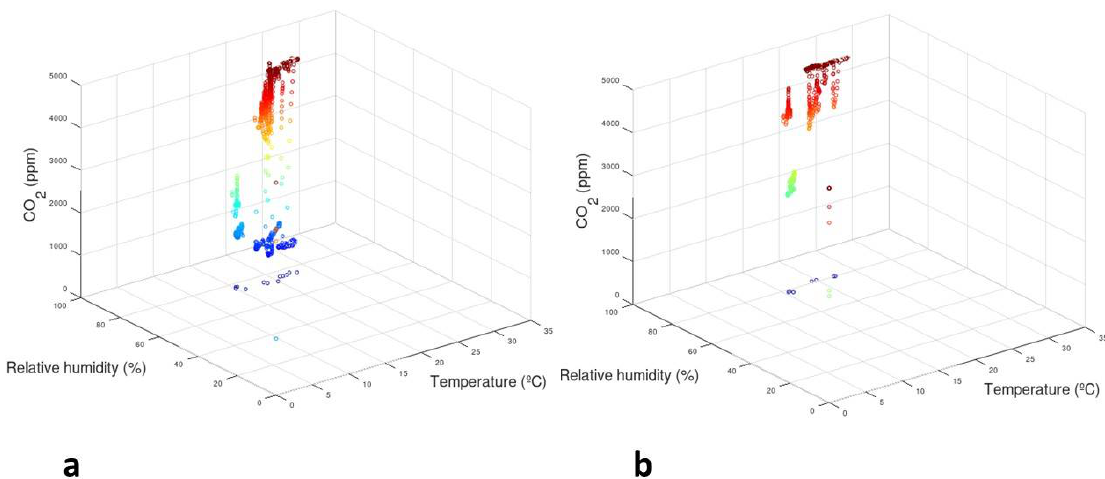
Figure 2. Graphical representation of relative humidity, temperature, and CO 2 data from barrels with maize grains stored for six months. ( a ) Maize from JC3 plot; ( b ) Maize from JC4 plot. The color of the markers is determined by the CO 2 level, from red (5000 ppm) to blue (0 ppm).